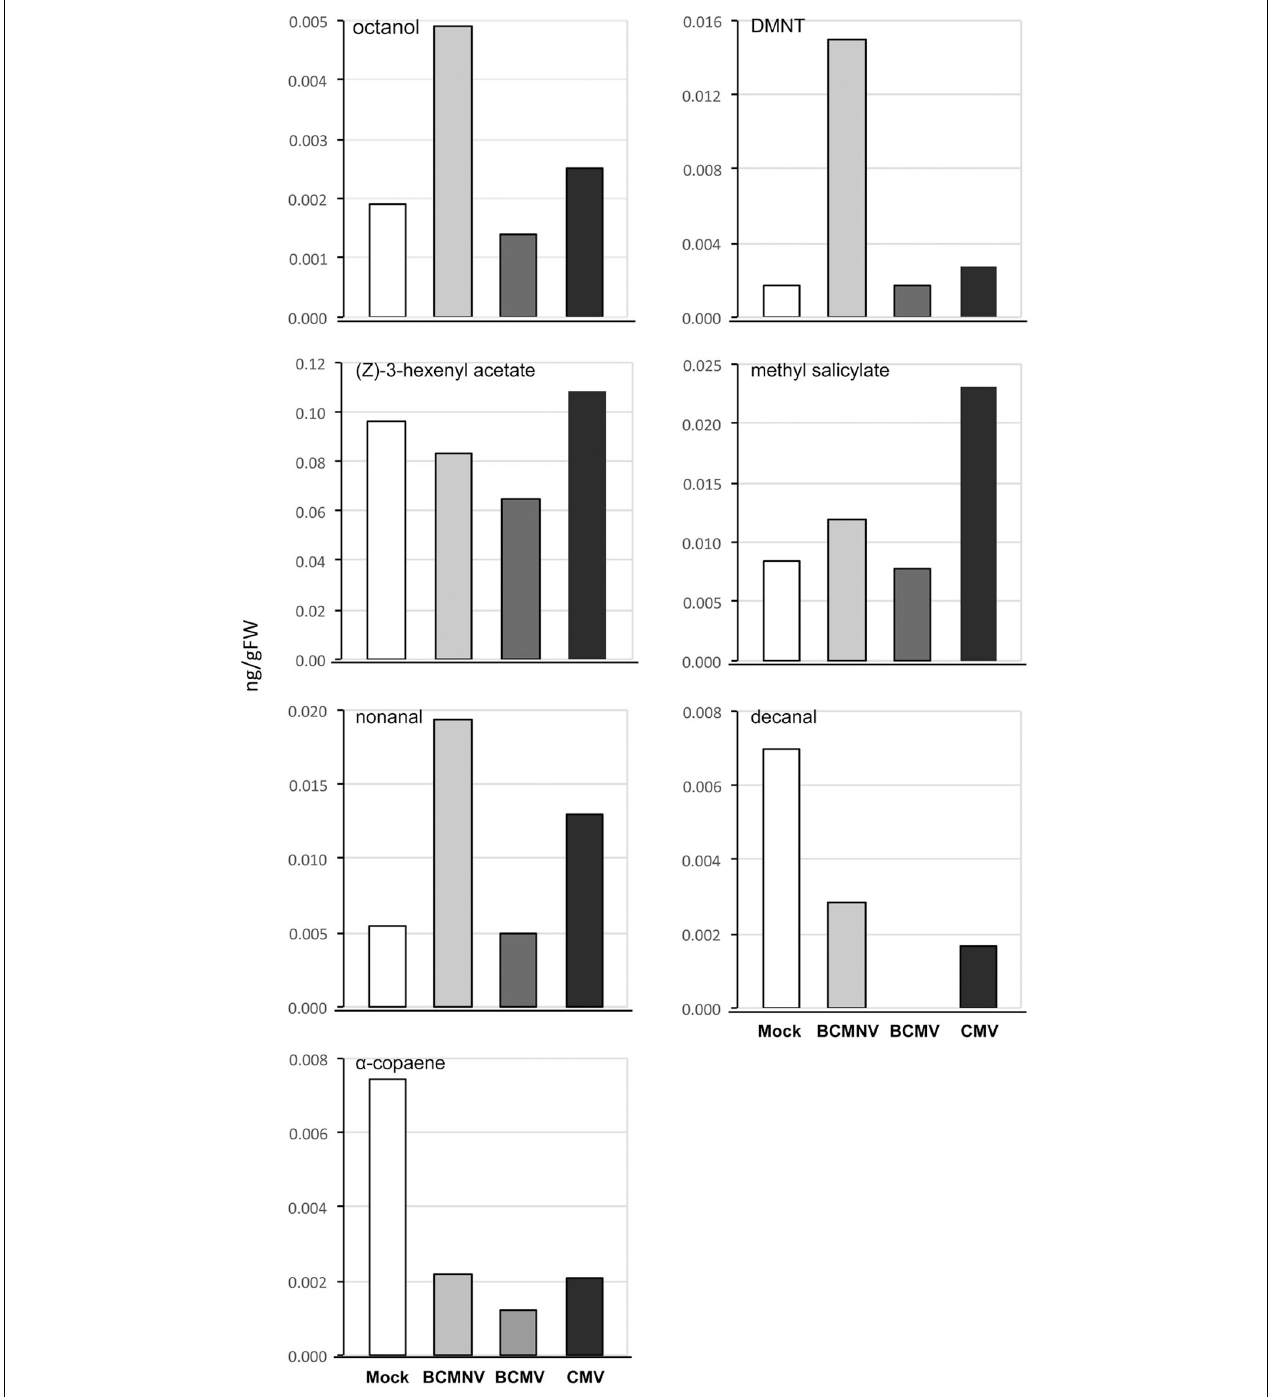
FIGURE 3 | Virus infection modifies emission of electrophysiologically active volatile organic compounds (VOCs) by bean plants. Virus infection engendered differences in the production levels of seven electrophysiologically active VOCs. Notably, α -copaene levels were diminished in VOC blends emitted by bean plants infected with bean common mosaic virus (BCMV), bean common mosaic necrosis virus (BCMNV), and cucumber mosaic virus (CMV). Decanal levels were also diminished by infection and the VOC was below the limits of detection of samples from headspace of BCMV-infected plants. Other VOC levels varied across different treatments. CMV and BCMNV infection appeared to elicit the most marked changes in levels of electrophysiologically active compounds. VOCs from CMV-infected plants had elevated methyl salicylate, nonanal, octanal and ( Z )-3-hexenyl acetate levels. Uniquely, BCMNV-infected plants had elevated ( E )-8-dimethyl-1,3,7- nonatriene (DMNT), octanol and nonanal levels. The data shows VOCs expressed as ng/gFW of bean plants collected over 5 days by dynamic headspace VOC collection and analyzed by GC-MS.